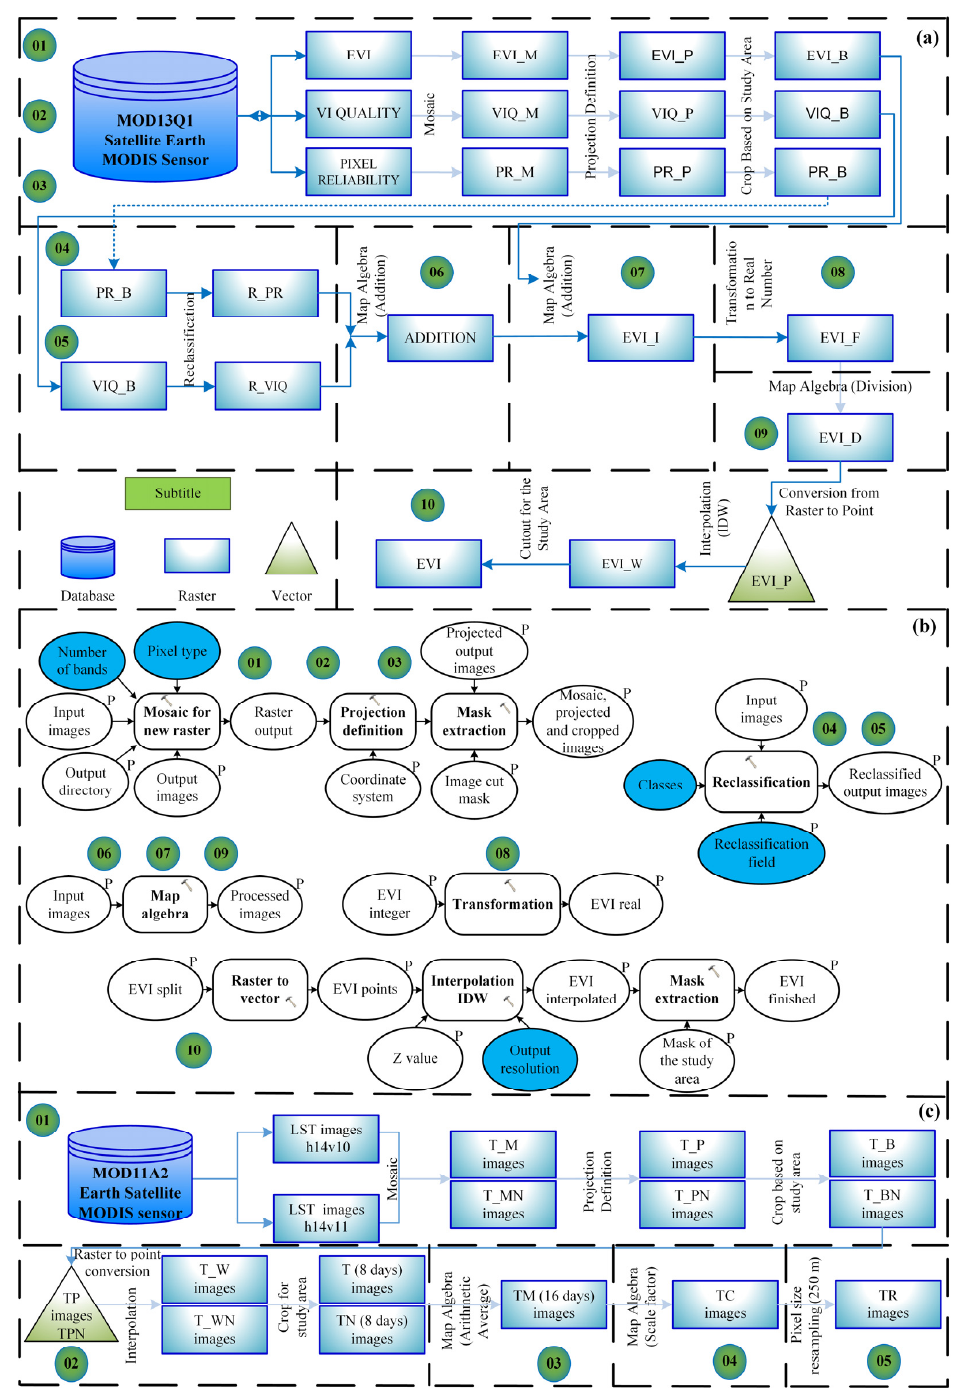
Figure 2. Methodological flowchart describing the preprocessing of the EVI images ( a ); steps of the developed model ( b ); preprocessing of the LST images ( c ).